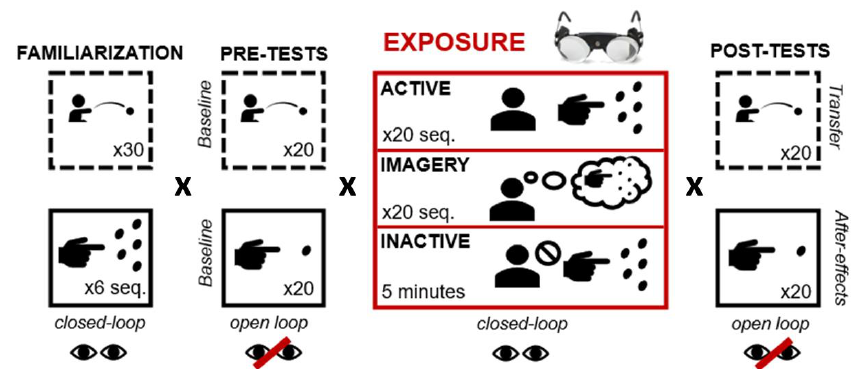
Figure 1. Experimental procedures included four steps: familiarization, pre-tests, exposure, and post-tests. Visual feedback was available during familiarization and post-tests and was precluded during pre- and post-tests. During familiarization, pre-tests, and post-tests, all participants performed both tasks in a pseudo-randomised order. During exposure, participants from the active group actively performed 20 sequences of pointing while those in the Imagery groups (MI+ and MI − ) imagined the same 20 sequences. Participants from the inactive group remained motionless during exposure and responded to trivial questions asked by the investigator.